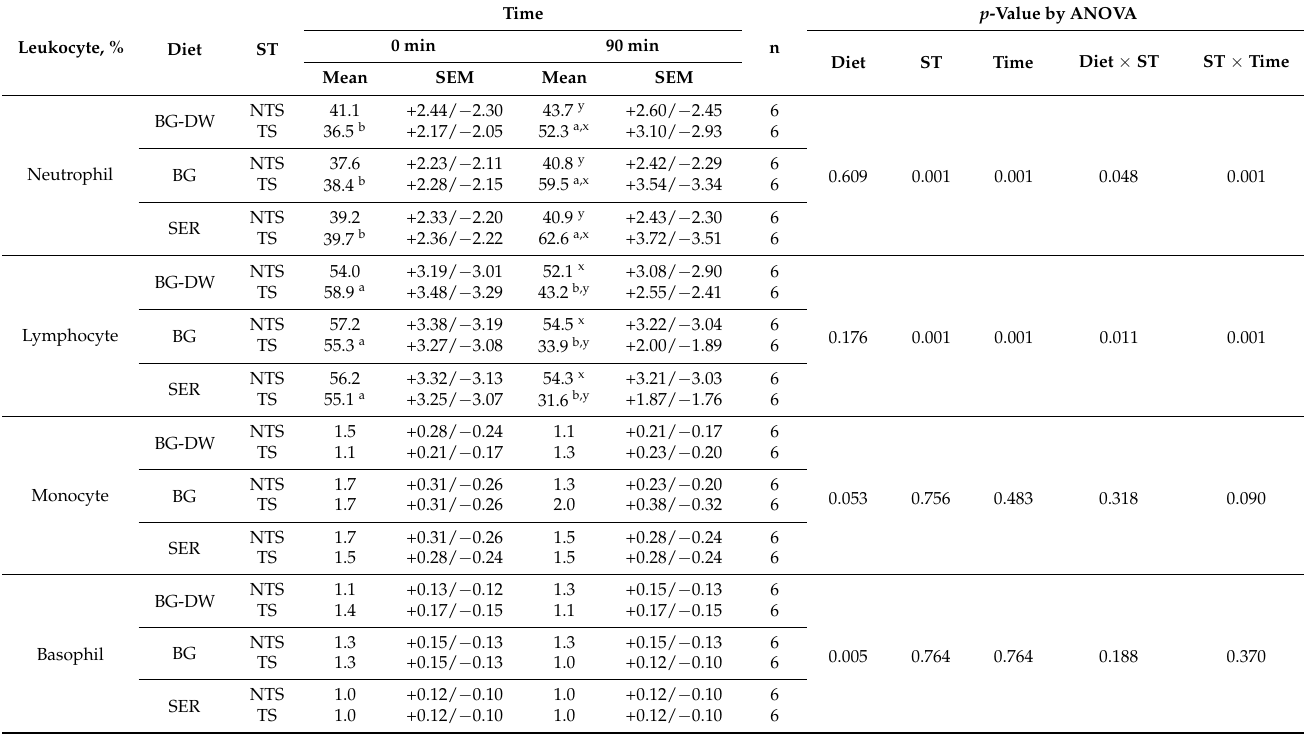
Table 3. Effects of diet (BG-DW: bermudagrass hay—dewormed; BG: bermudagrass hay; SER: sericea hay) and stress treatment (ST: Non-Transported, NTS; Transported, TS) on differential leukocyte